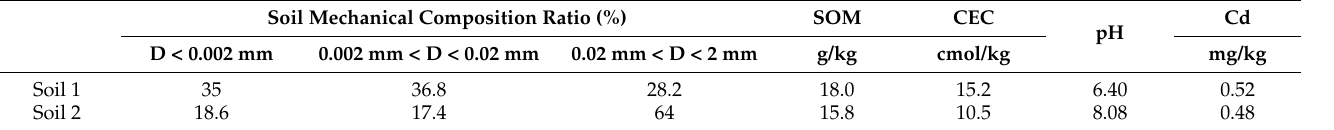
Table 1. Basic physical and chemical properties of soils in two sedimentary environments.